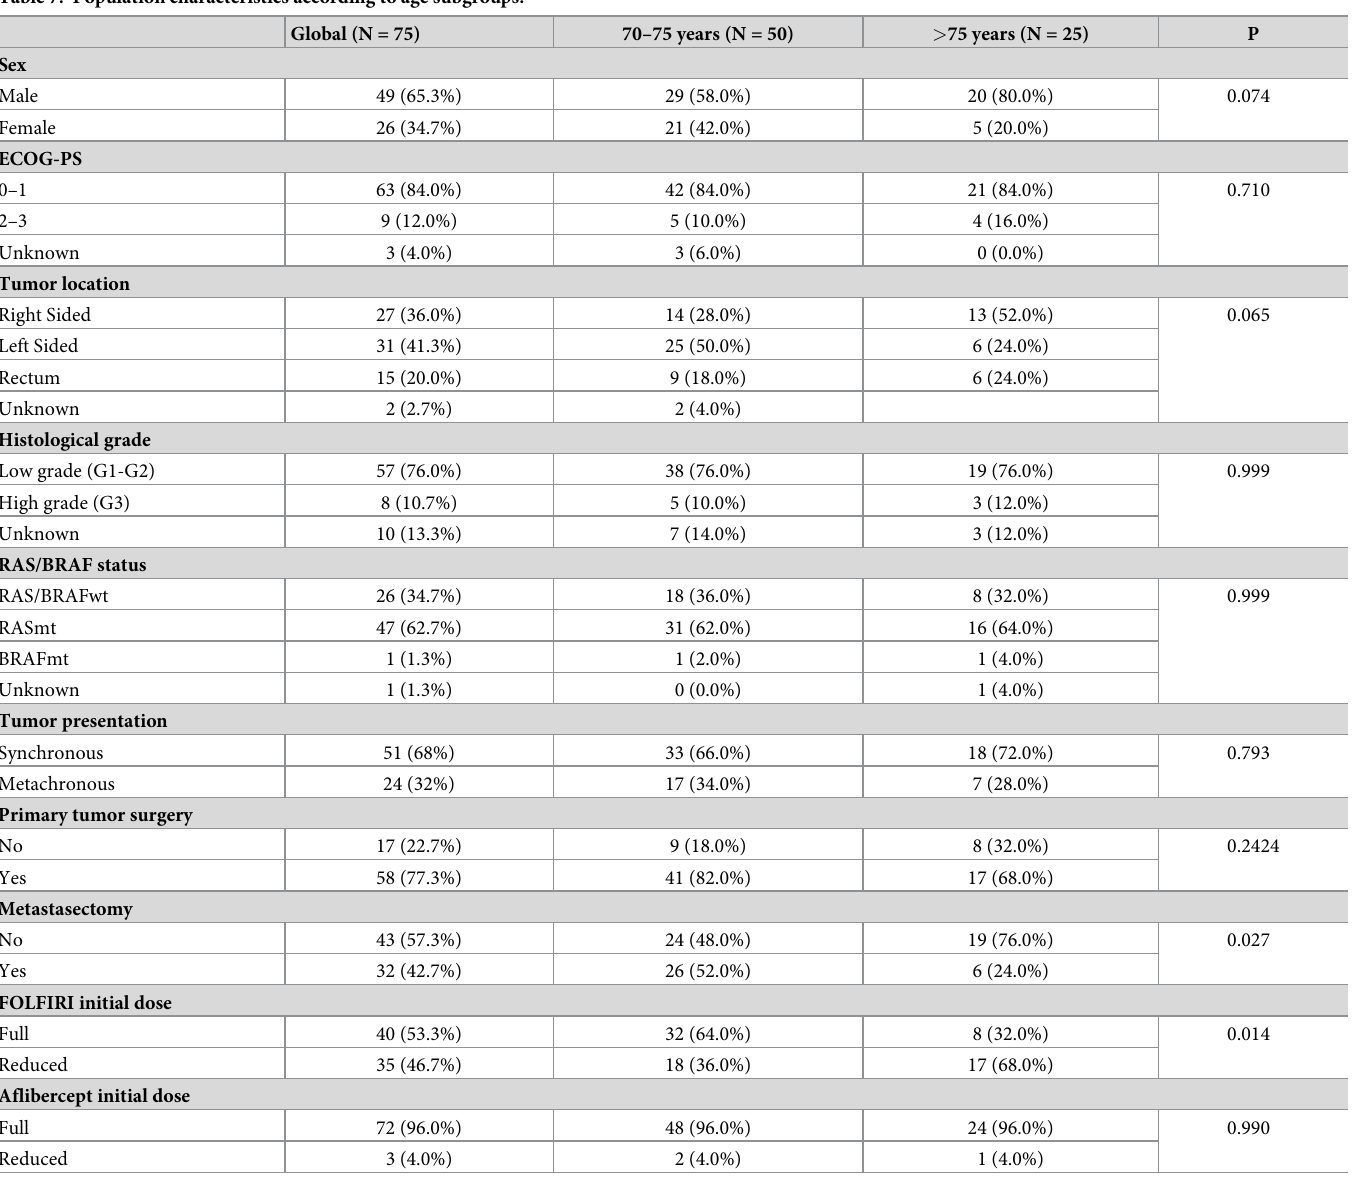
Table 7. Population characteristics according to age